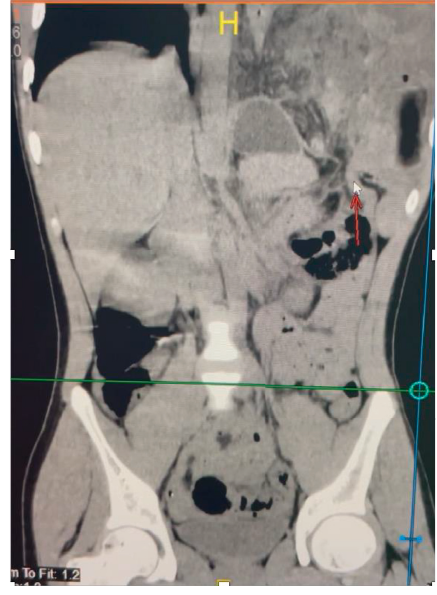
Figure 2: The thoracoabdominal CT scan without contrast showing a left-sided diaphragmatic defect (indicated by the white arrow) with herniation of the bowel into the thorax cavity (coronal